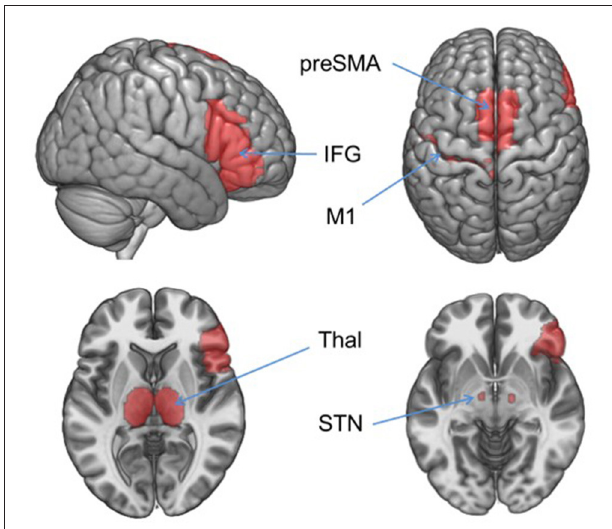
FIGURE 1 | Inhibitory control network mask. Hypothesis-driven fMRI analyses were restricted to the regions in this mask which included right inferior frontal gyrus (IFG), left precentral gyrus (M1), and bilateral thalamus (Thal), subthalamic nucleus (STN), and pre-supplementary motor area (preSMA). Areas were defined in WFU Pickatlas.